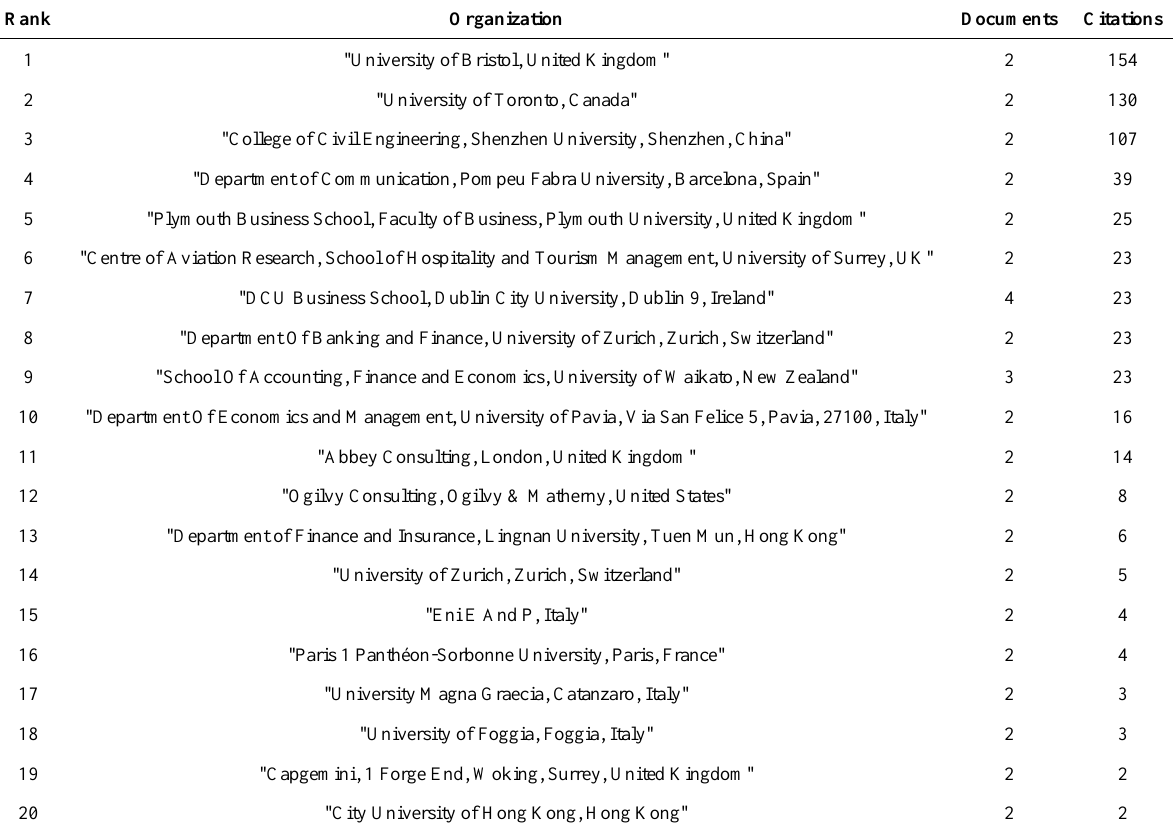
Table 5. Organization-wise published reputation risk